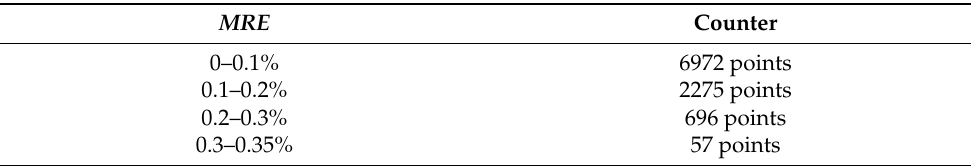
Table 2. Mean relative error ( MRE ) distribution of the 10,000